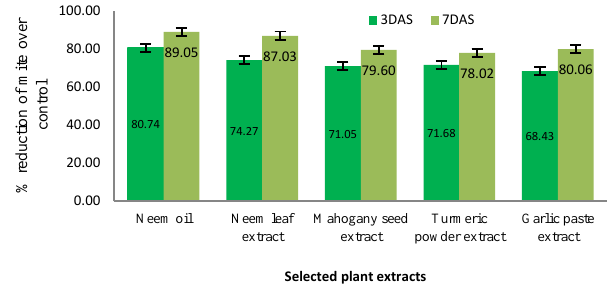
Figure 2: Effect of different plant extracts on the reduction of yellow mite infested Plant over control